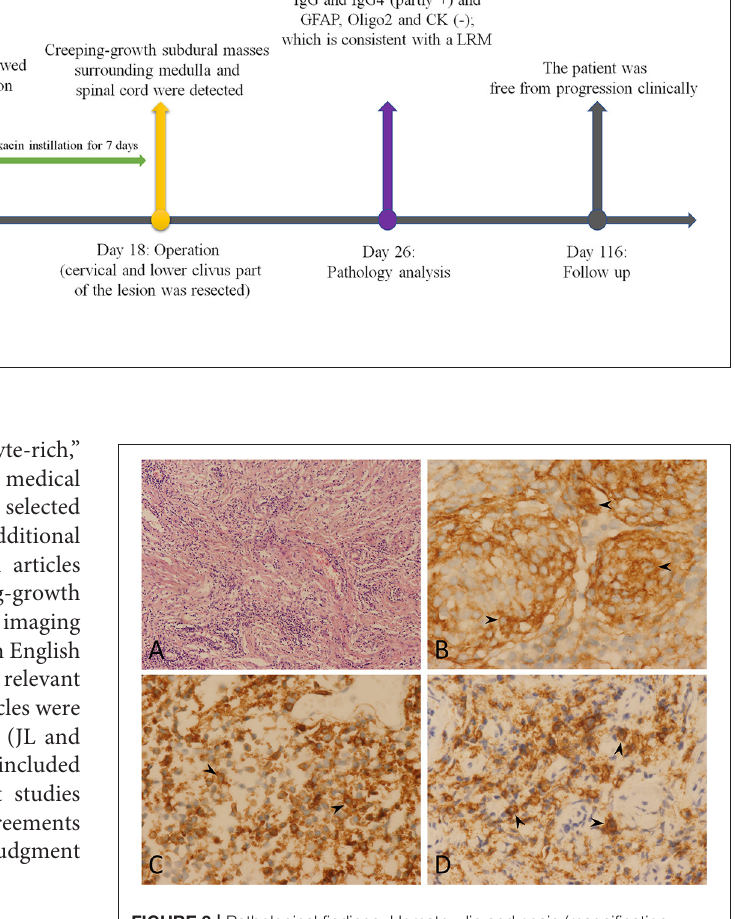
FIGURE 3 | Pathological findings. Hematoxylin and eosin (magnification, × 100) (A) showing lymphoplasmacytes infiltrated the tumor stroma, overshadowing the meningioma component. Immunohistochemistry testing showed epithelial membrane antigen positive ( arrowheads ) (magnification, × 400) (B) , CD20 positive ( arrowheads ) (magnification, × 400) (C) , and CD138 positive ( arrowheads ) (magnification, × 400) (D) . In conclusion,